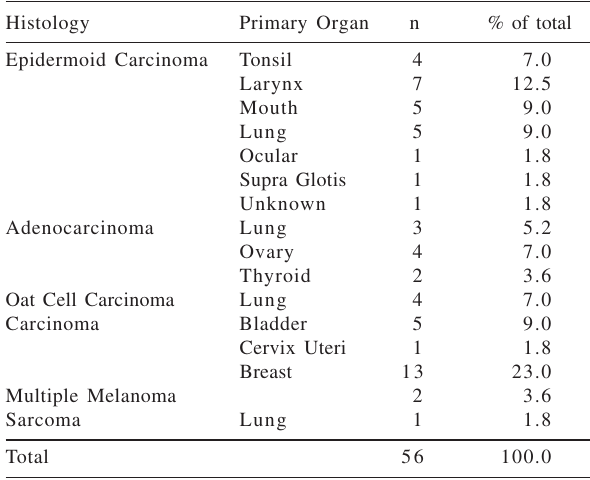
Table 1 - Histology and primary organ affected in the cancer